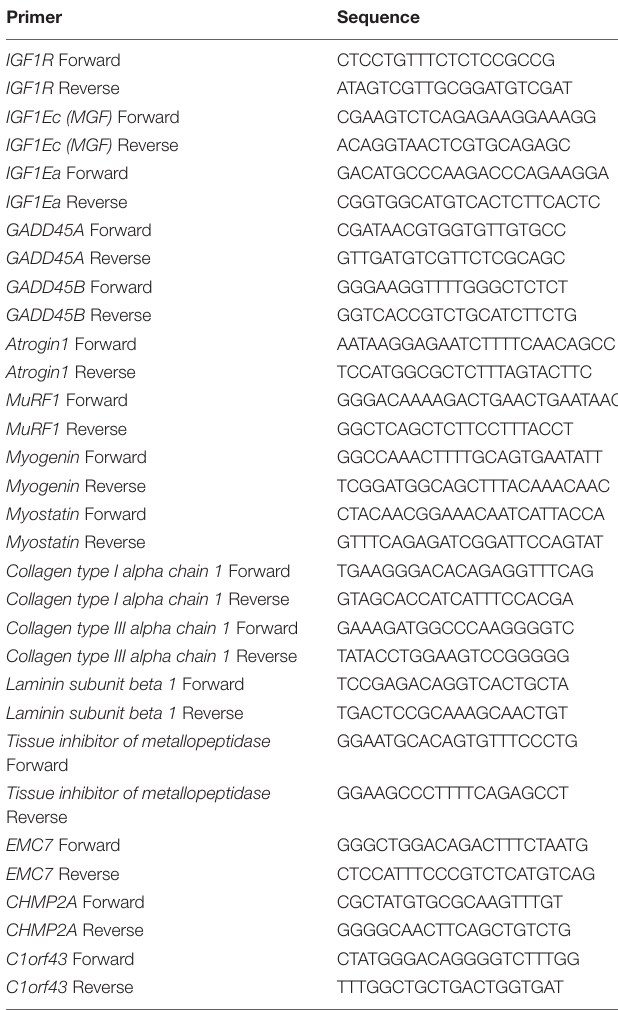
TABLE 1 | mRNA primer